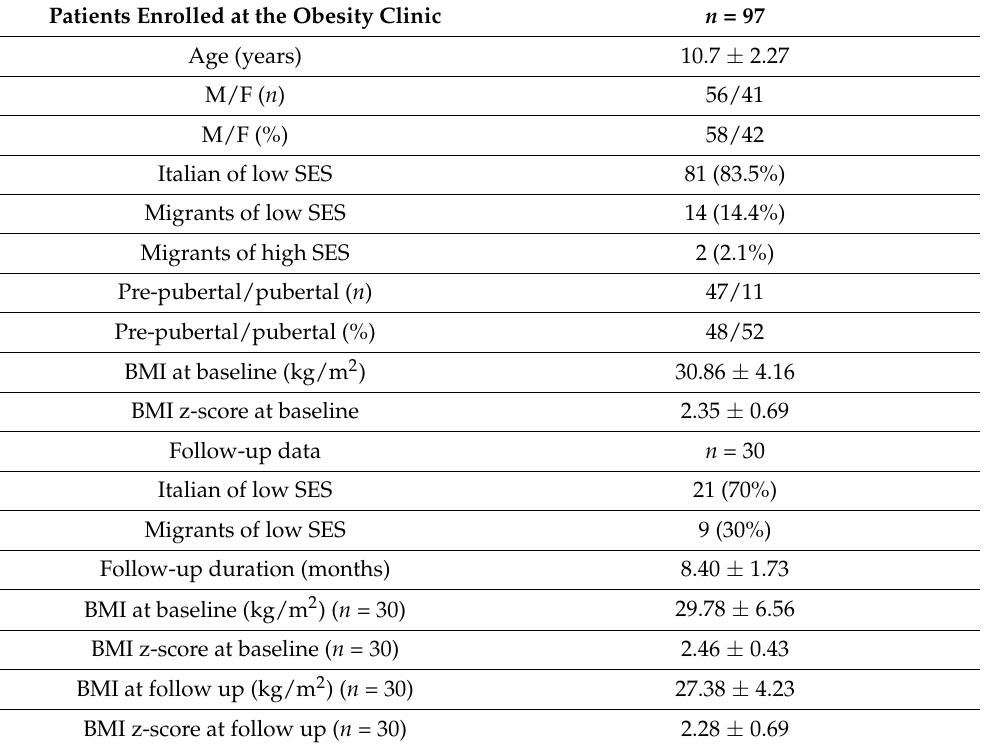
Table 3. Anthropometric and lifestyle data of the overweight and obese subjects enrolled in the outpatient clinic.